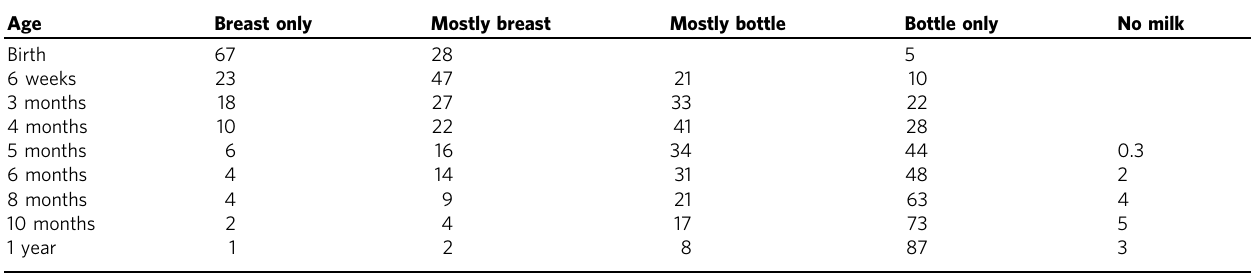
Table 1 Incidence of breast, bottle and combined feeding methods at various ages as percentage of